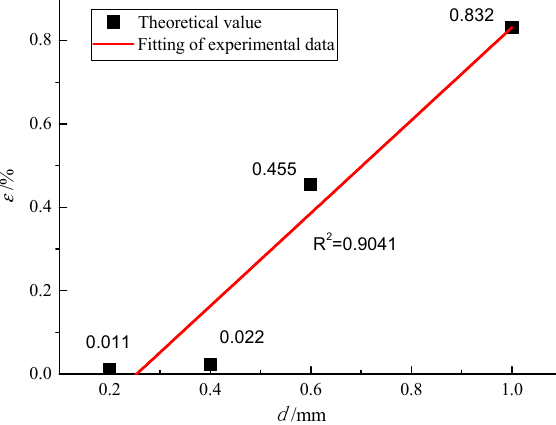
Figure 15. The relationship between the maximum generalized strain at the crack tip and crack width ( d ).